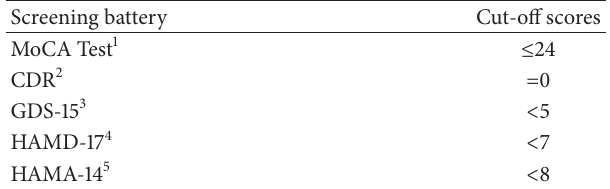
Table 1: Screening tests for MCI cut-off